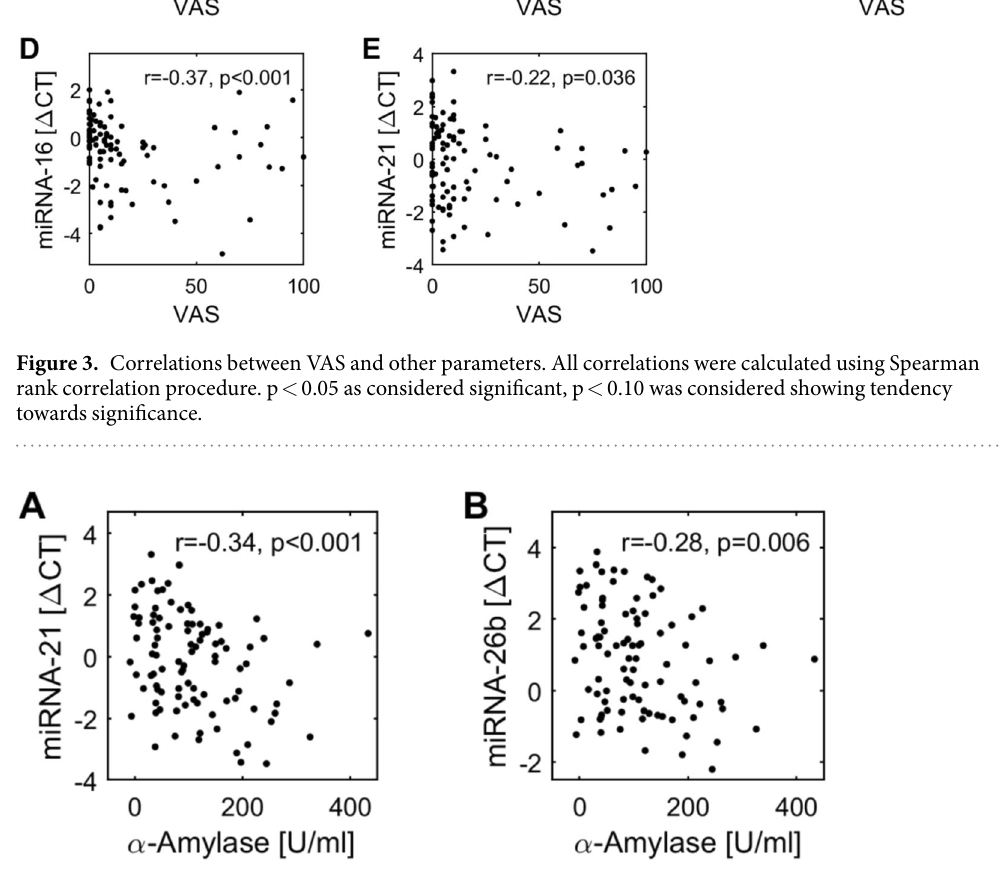
Figure 4. Correlations between alpha-amylase and miR-21/miR-26b. All correlations were calculated using Spearman rank correlation procedure. p < 0.05 as considered significant, p < 0.10 was considered showing tendency towards